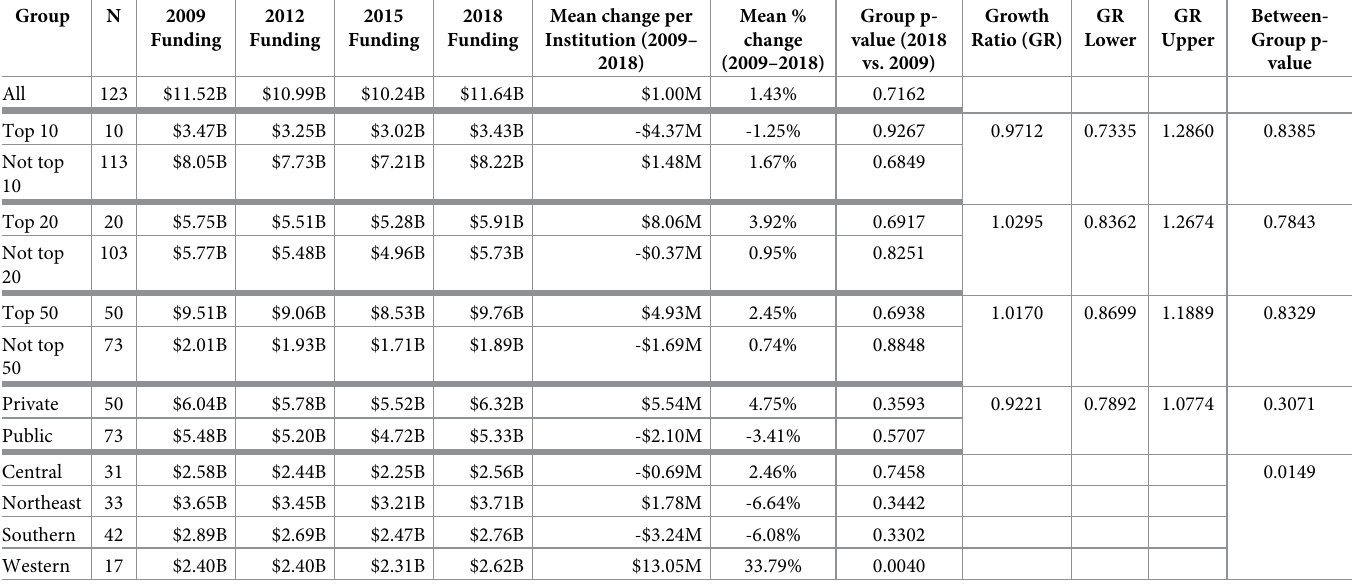
Table 2. NIH adjusted funding over time and tests for significant change within- and